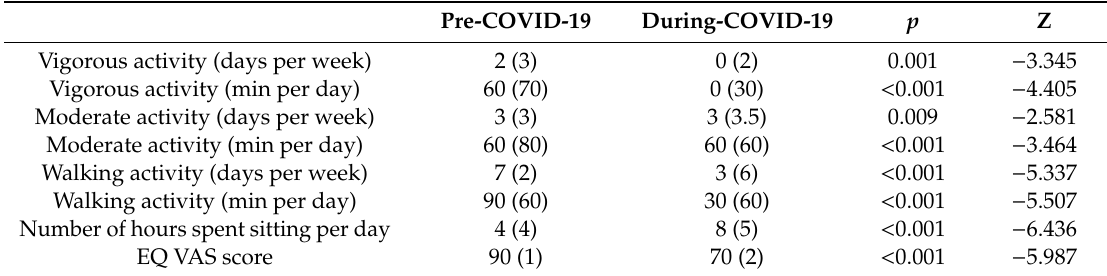
Table 3. Results of the Wilcoxon tests for continuous